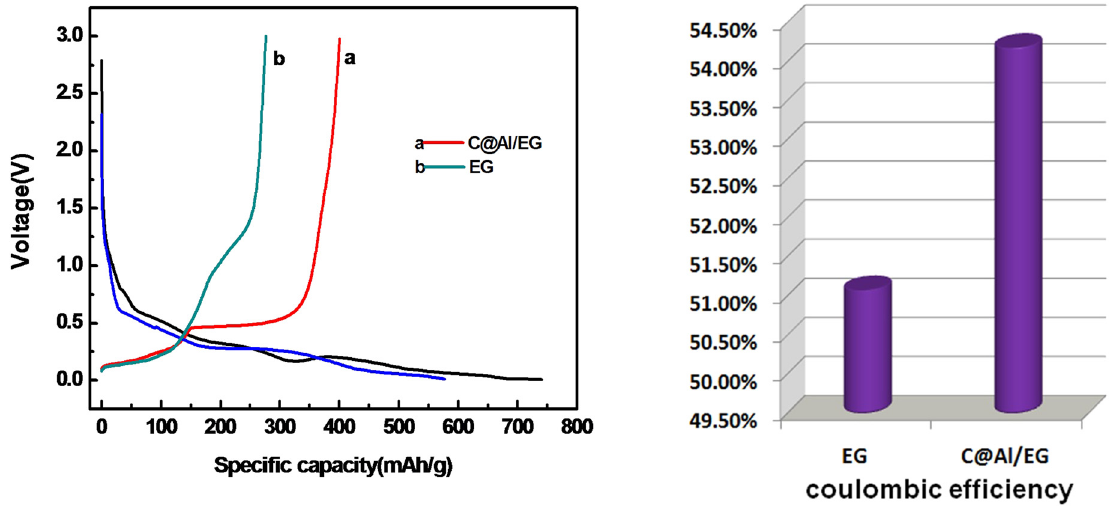
Figure 8: The initial charge – discharge curves and the coulombic e ffi ciency of EG and C@Al – EG composites.